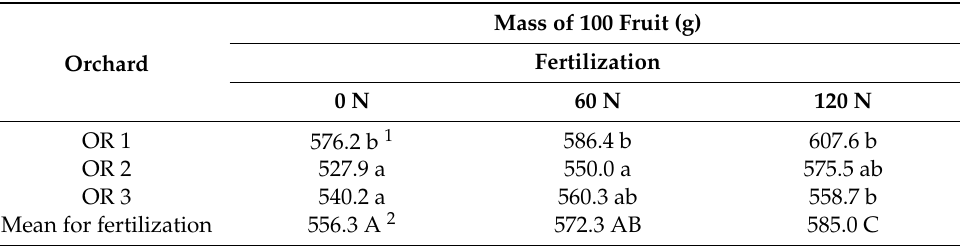
Table 6. The weight of fruits of the sour cherry cv. ‘Łut ó wka’ depending on the age of the orchard and nitrogen fertilization in the years 2006–2013.